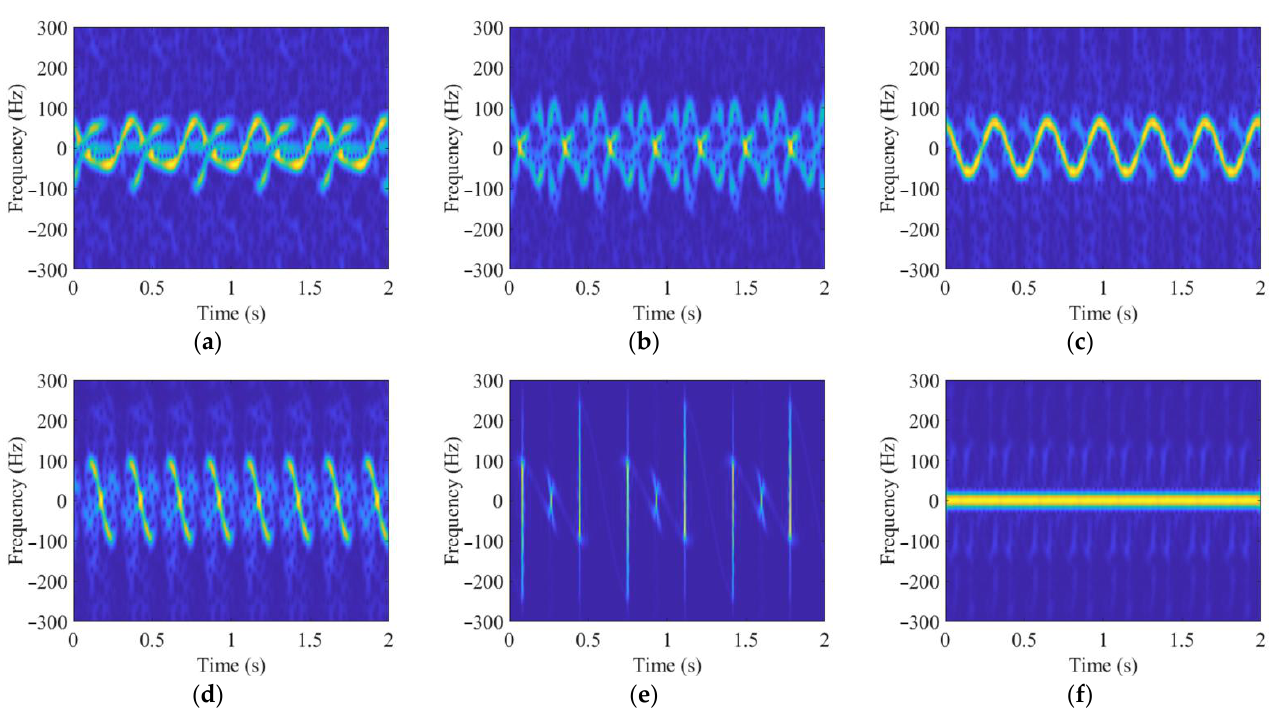
Figure 7. TF spectrums of the six targets. ( a ) Warhead 1; ( b ) warhead 2; ( c ) warhead 3; ( d ) decoy 1; ( e ) decoy 2; ( f ) decoy 3.